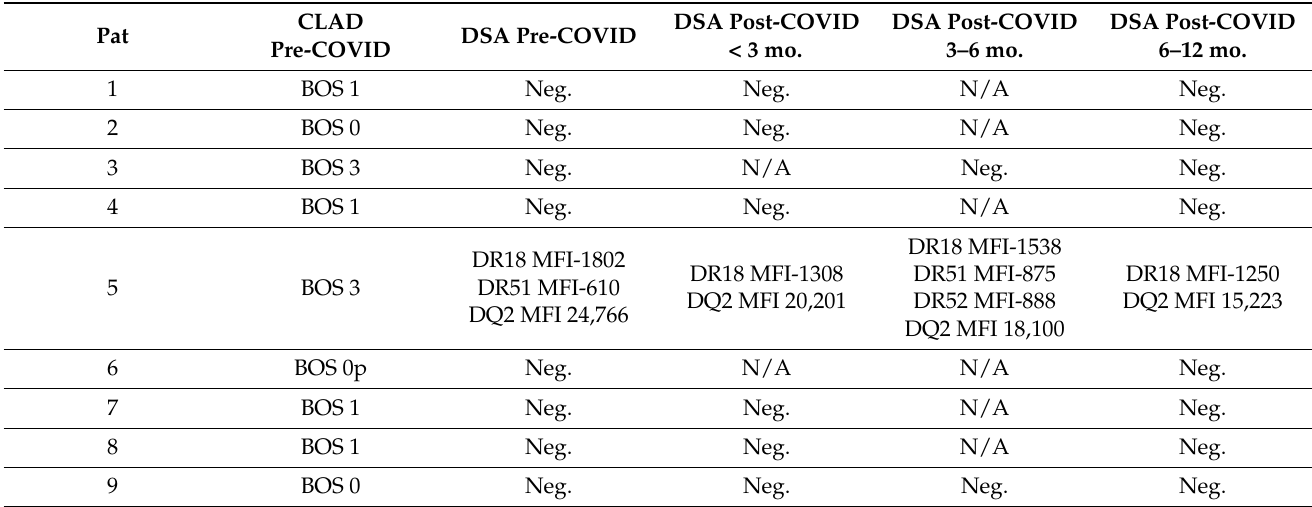
Table 4. Pre-COVID chronic lung allograft dysfunction (CLAD) and donor-specific antibody (DSA) monitoring (moderate